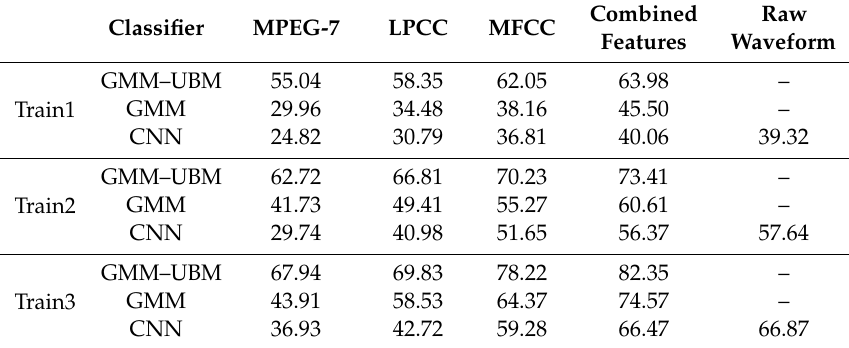
Table 3. Accuracy of individual violin recognition (%).